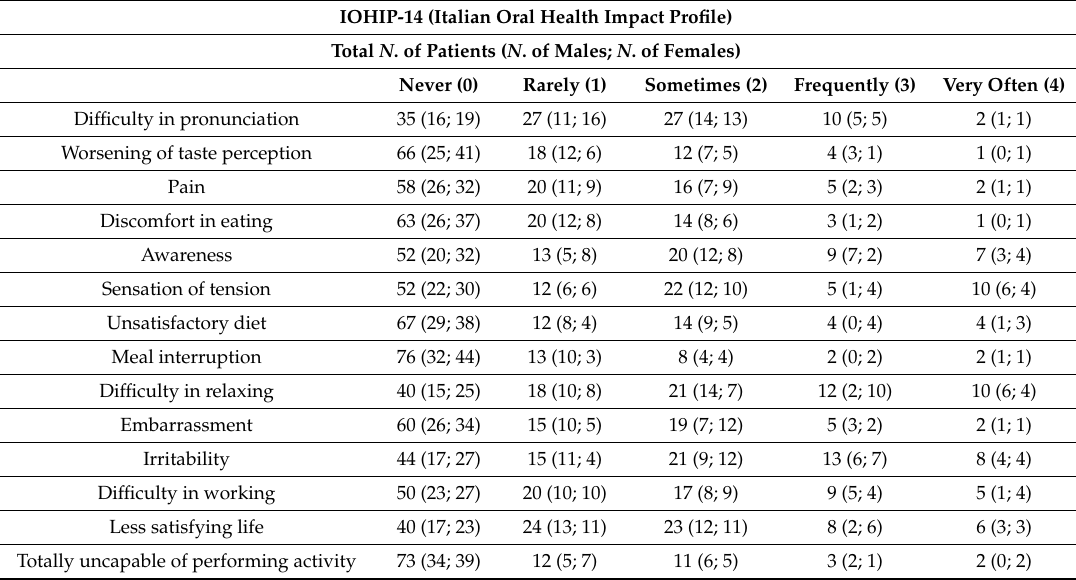
Table 3. IOHIP-14—Italian Oral Health Impact Profile